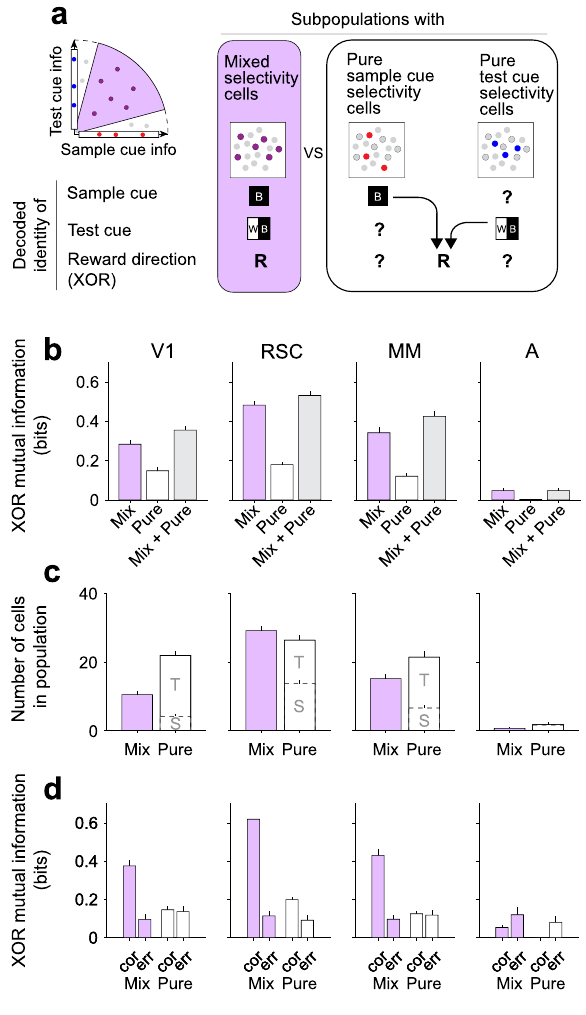
Fig. 6 | Population code for XOR in populations of mixed selectivity or pure selectivity cells. a Left: Partitions for mixed selectivity cells and pure selectivity cells based on their information. Right: Mixed selectivity cells encode the identity of thesample cue,testcue,andrewarddirection(XOR)(purplerectangle).Neither pure sample cue selectivity cells nor pure test cue selectivity cells encode XOR by themselves, but XOR can be nonlinearly decoded by combining the two types of pureselectivity cells (white rectangle). b Mutualinformation between the true and decoded XOR in populations of mixed selectivity cells (purple; 15 ˚ ≤ θ < 75 ˚ in Fig. 4h, correct trials), pure selectivity cells (white; θ = 0 ˚ and θ = 90 ˚ from Fig. 4i, correct trials), and both types of cells combined (gray). Error bars indicate mean ± s.e.m. V1: n =11 sessions (1783 trials), RSC: n =12 sessions (1685 trials), MM: n =7 sessions (1230 trials), A: n =5 sessions (822 trials). Mutual information in mixed selectivity cells was signi fi cantly greater than that in pure selectivity cells in V1 ( p =0.0002), RSC ( p <10 − 4 ), MM ( p <10 − 4 ), but not in A ( p =0.049). All p values were calculated by bootstrap of cells in each session for panels ( b – d ) and the signi fi cance threshold was adjusted by Bonferroni correction with α = 0.05 to account for 4 area-wise comparisons for panels ( b – d ), and 6 between-area com- parisons for panel ( d ). c Number of cells classi fi ed as mixed selective or pure selective (T=test cue selective; S=sample cue selective) per session. Error bars indicatemean±s.e.m.V1: n =11sessions,RSC: n =12sessions,MM: n =7sessions,A: n =5 sessions. The number of cells was signi fi cantly larger for pure selectivity cells than for mixed selectivity cells in V1 ( p <10 − 4 ) and MM ( p =0.004), but not in RSC ( p =0.22) and A ( p =0.051). d Mutual information between the true and decoded XOR, computed separately on correct and error trials. Error bars indicate mean ± s.e.m. V1: n =11 sessions (1476 correct/307 error trials), RSC: n =12 sessions (1420 correct/265 error trials), MM: n =7 sessions (1009 correct/221 error trials), A: n =5sessions(753correct/69errortrials).Formixedselectivitycells,thedifference betweencorrectanderrorwassigni fi cantlydifferentfromzeroinV1( p <10 − 4